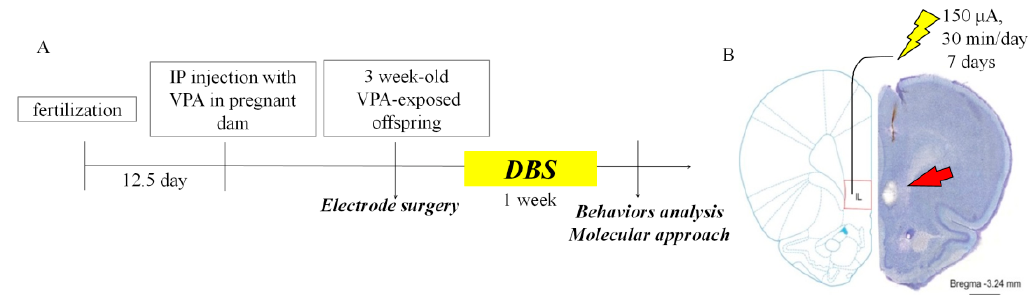
Figure 6. Experimental design of ILPFC DBS applied to the VPA-exposed offspring. ( A ) Schematic representation flow chart of the experimental design; ( B ) verification of unilateral DBS electrode placement on the right-hand side by Nissl staining of the ILPFC. Scale bar, 1 mm.